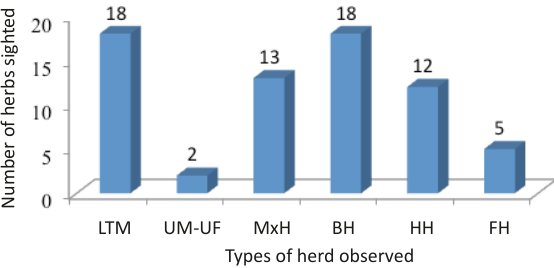
Figure 3. Variation in sighting of different types of herds of Blackbuck recorded in and around Lalpur Jheel, Dobhi Village from March 2017 to February 2018. LTM—lone territorial male | UM-UF—unimale- unifemale | MxH—mixed herd | BH—bachelor herd | HH—harem herd | FH—female herd.